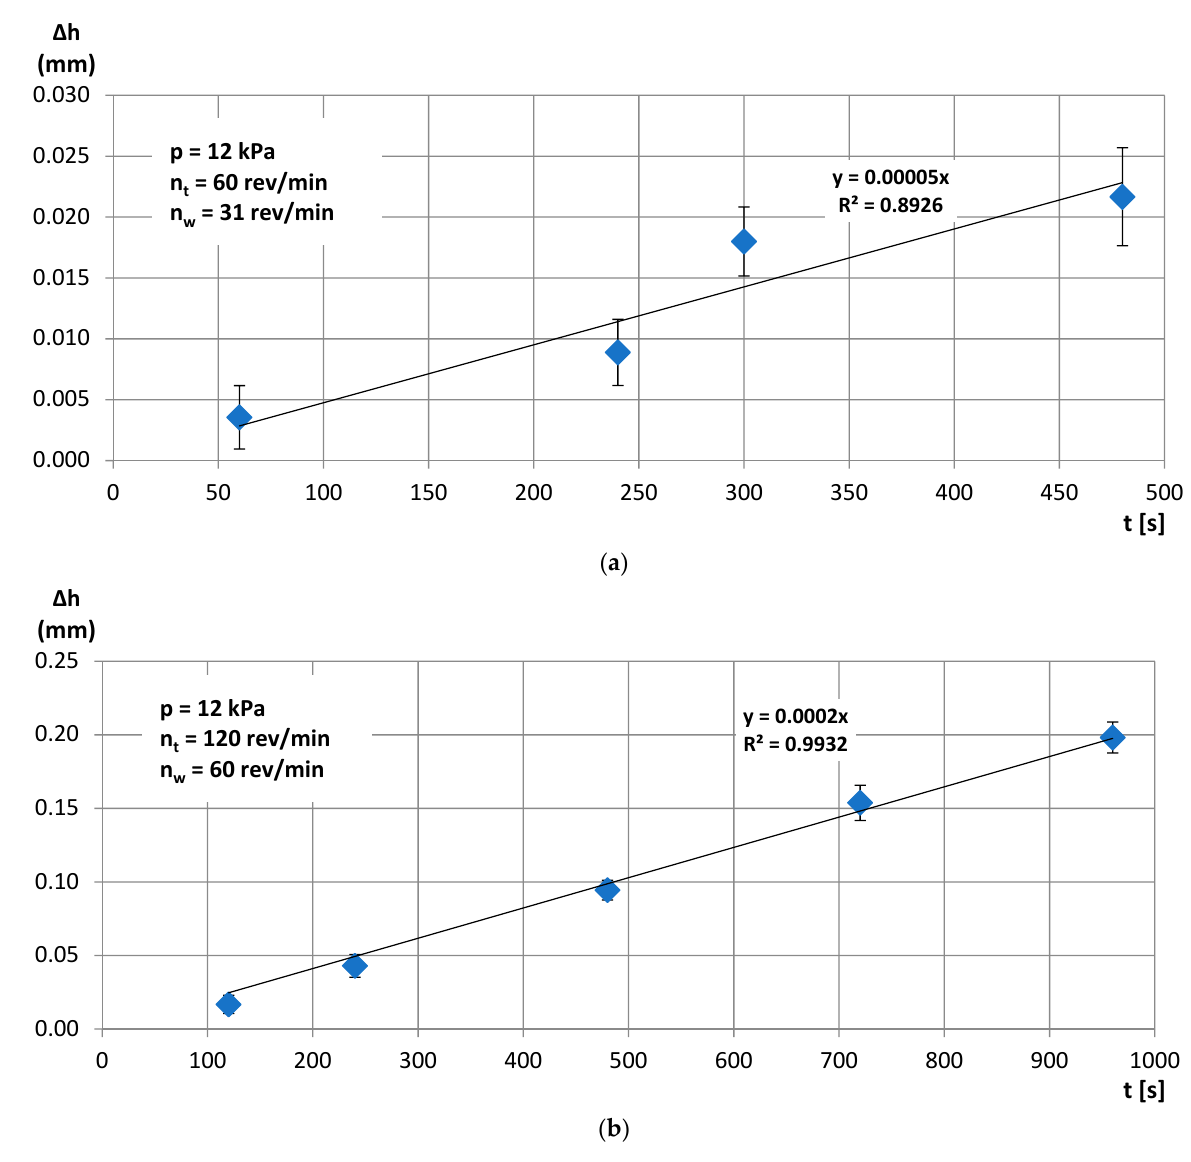
Figure 5. Cumulative linear material loss obtained in single-sided lapping of Al 2 O 3 technical ceramics during tests T2 ( a ) and T3 ( b ); error bars show ± the standard deviation.